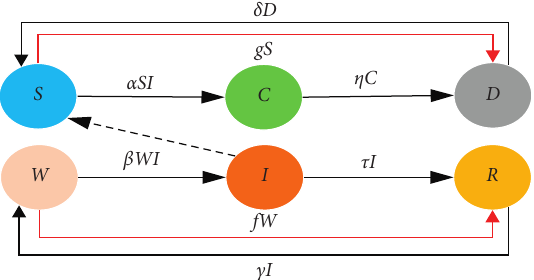
Figure 2: State transition diagram of the proposed model (dashed lines on the graph represent DDoS attacks, and red lines represent defense